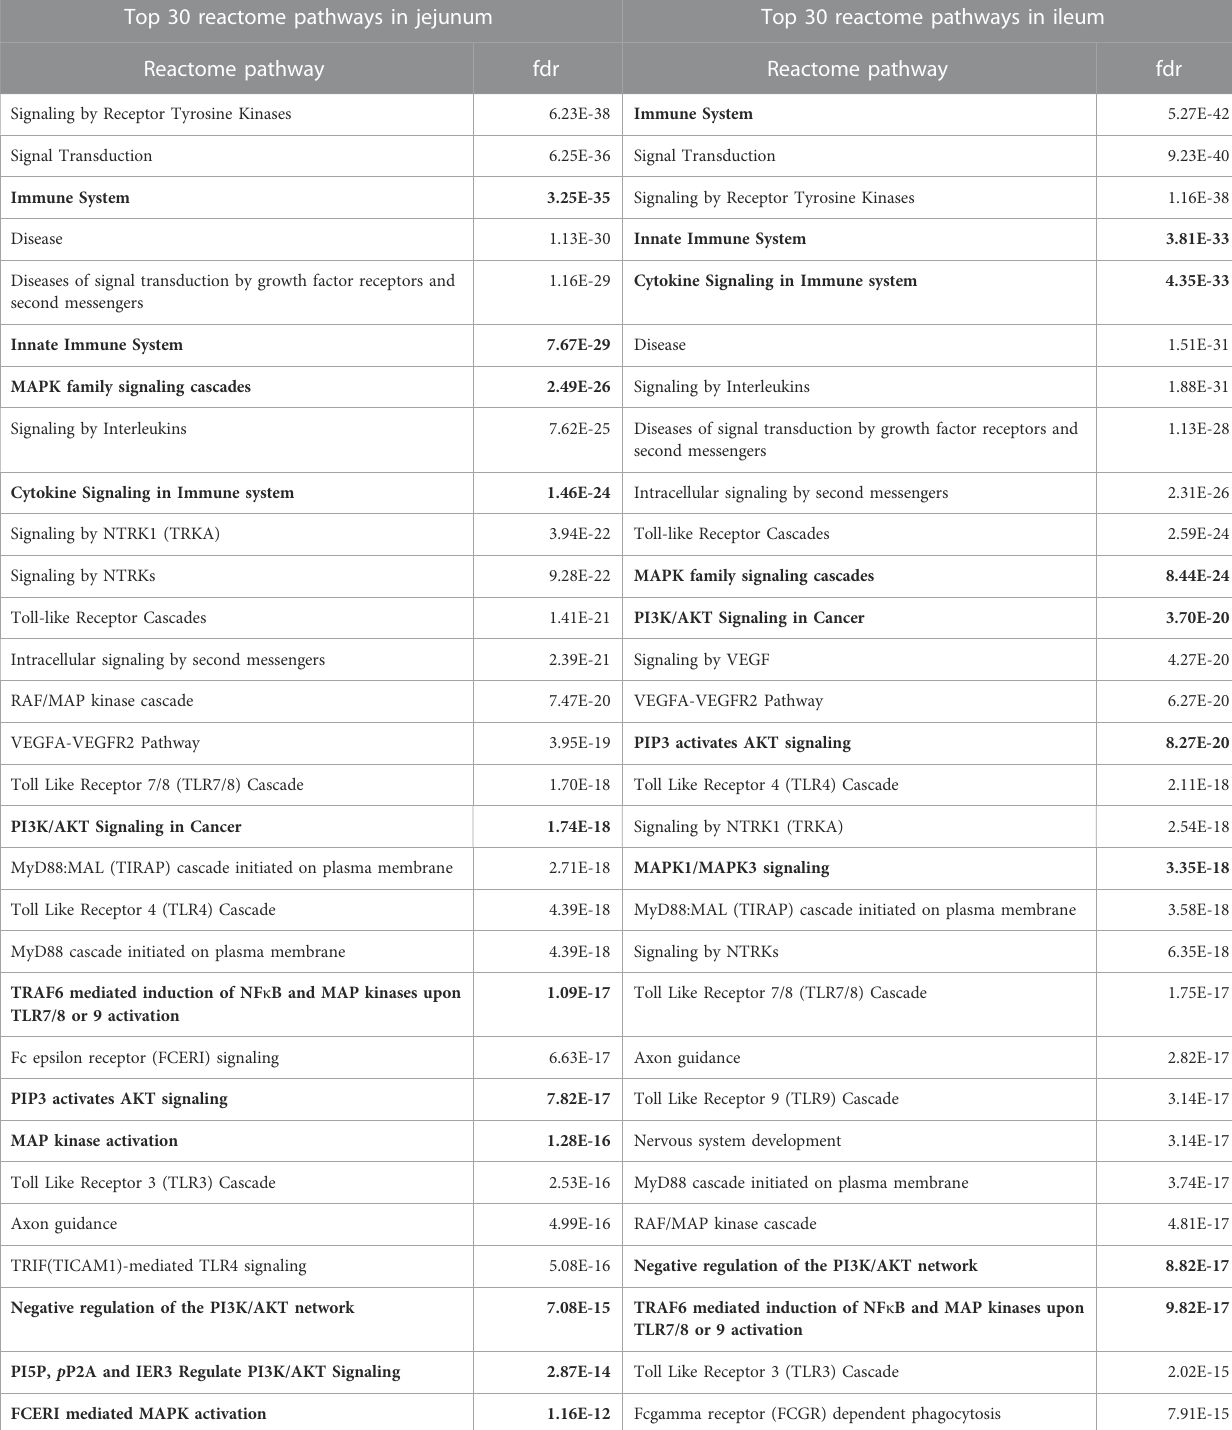
TABLE 3 Top 30 Reactome Pathways Enriched in Jejunum and Ileum. The top 30 Reactome pathways, as determined by STRING, for each tissue are represented here. Proteins showing statistically signi fi cant differential phosphorylation status between treatment and control fed birds for each tissue were provided to STRING for protein-protein interaction analysis. False Discovery Rate (fdr) is a signi fi cance metric ( p -value) provided by STRING. p -values are generated using the Benjamini – Hochberg procedure. Key pathways in immune and metabolic regulation have been